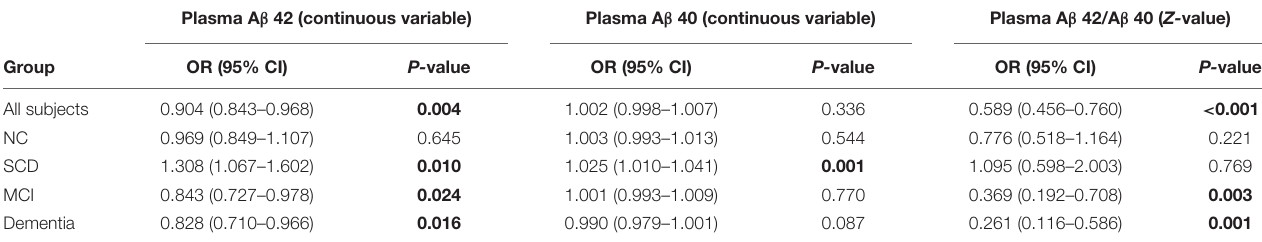
TABLE 4 | Logistic regression analysis on relationship between plasma biomarkers and AV45 PET positive in different